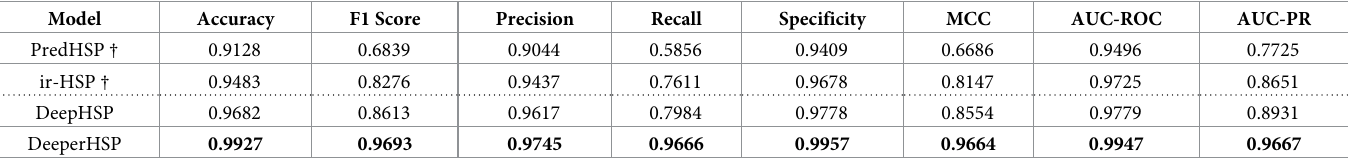
Table 4. Comparison of overall classification performance using 5-fold